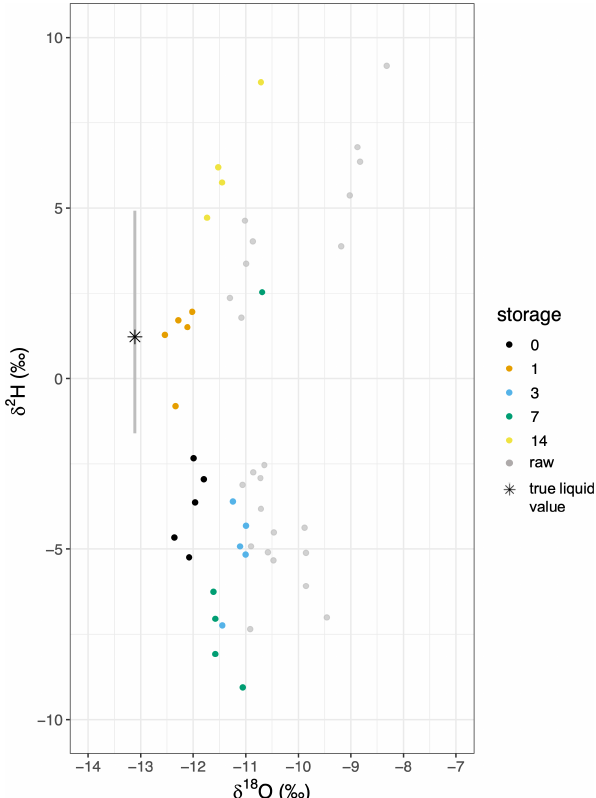
Figure 8. Dual isotope plot for a comparison of in situ and corrected VSVS data by storage time for the field trial. The in situ value is in- dicated by a star including the standard deviation represented as a grey bar. The uncorrected VSVS data are represented by grey dots, while the corrected data is indicated by color for the respective stor- age